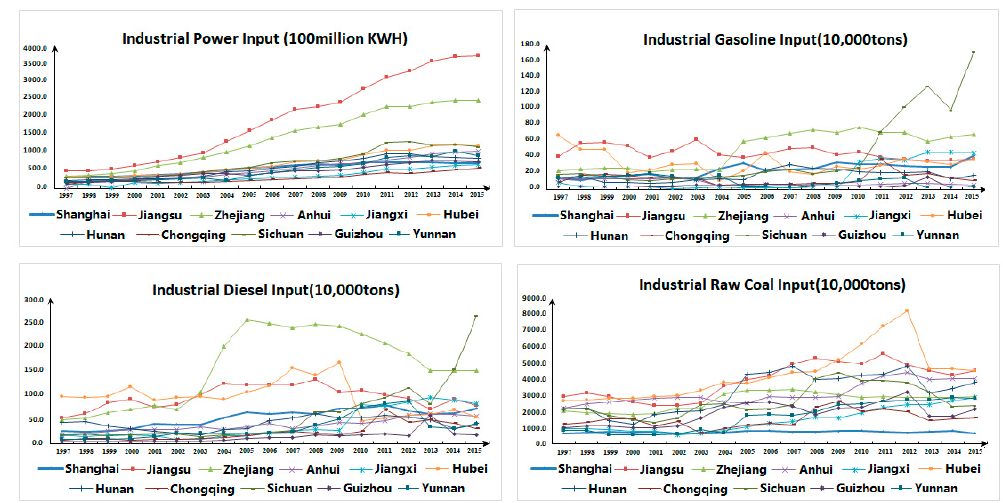
Figure 2. Industrial Input Diagram of the Yangtze River Economic Belt.